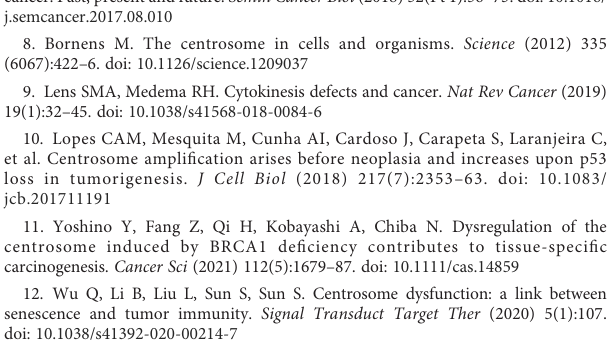
SUPPLEMENTARY FIGURE 1 Functional analysis of centrosome-related DEGs and multivariate Cox regression analysis of forest plots (A) GO enrichment of downregulated centrosome-related DEGs. (B) KEGG pathways of downregulated centrosome-related DEGs. (C) Multivariate Cox regression analysis of prognostic factors based on cross-validation and least partial likelihood deviation further argued for independent prognostic factors. SUPPLEMENTARY FIGURE 2 Subgroup survival analysis and functional analysis between high/low-risk groups (A) Kaplan – Meier survival for OS curve of the patients in the high/ low-risk groups in stage I breast cancer patients. (B) Kaplan – Meier survival for OS curve of the patients in the high/low-risk groups in stage II breast cancer patients. (C) Kaplan – Meier survival for OS curve of the patients in the high/ low-risk groups in stage III breast cancer patients. (D) Kaplan – Meier survival for OS curve of the patients in the high/low-risk groups in stage IV breast cancer patients. (E) Kaplan – Meier survival for OS curve of the patients in the high/low-risk groups in LumA breast cancer patients. (F) Kaplan – Meier survival for OS curve of the patients in the high/low-risk groups in LumB breast cancer patients. (G) Kaplan – Meier survival for OS curve of the patients in the high/low-risk groups in Her2 breast cancer patients. (H) Kaplan – Meier survivalforOScurveofthepatients inthehigh/low-risk groupsinBasalbreast cancer patients. (I) GO enrichment of centrosome-related DEGs in high-risk subgroup. (J) KEGG pathways of centrosome-related DEGs in high- risk subgroup. SUPPLEMENTARY FIGURE 3 Immune cell in fi ltration in high/low-risk subgroups. (A) Different estimated proportions of XCELL immune cell types in high/low-risk subgroups. (B) Different estimated proportions of TIMER immune cell types in high/low- risk subgroups. (C) Different estimated proportions of QUANTISEQ immune cell types in high/low-risk